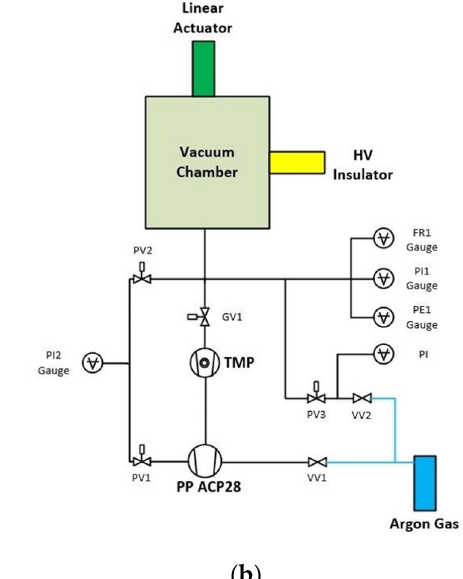
Figure 2. ( a ) Rendering of the assembled vacuum system, whose numbered components are described in Table 1; ( b ) vacuum system scheme. Table 1. Description of the vacuum system components represented in Figure 2. Item N.